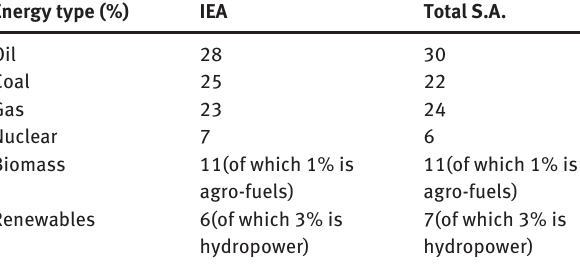
Table 1 The energy mix in 2030, according to the IEA and Total. Source: International Energy Agency and Total.